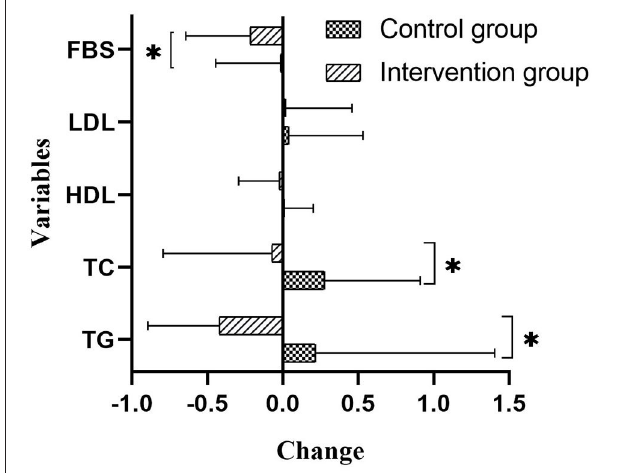
FIGURE 3 | Differences of Fasting blood lipids and glucose between intervention and control groups (mmol/L). Compared between intervention and control groups with ANCOVA test and adjusting for the age, sex, and baseline amounts. FBS, fasting blood sugar; LDL, low density lipoprotein; HDL, high density lipoprotein; TG,